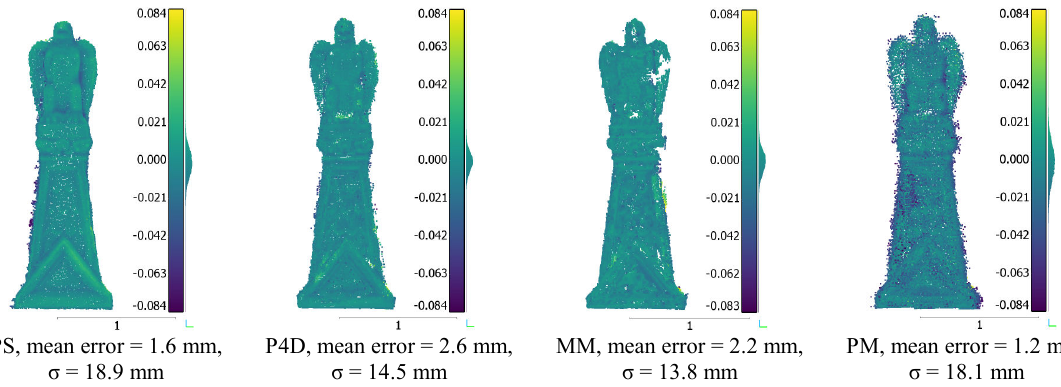
Figure 8. Comparison of dense matching results of the St. Matthew’s gargoyle to TLS